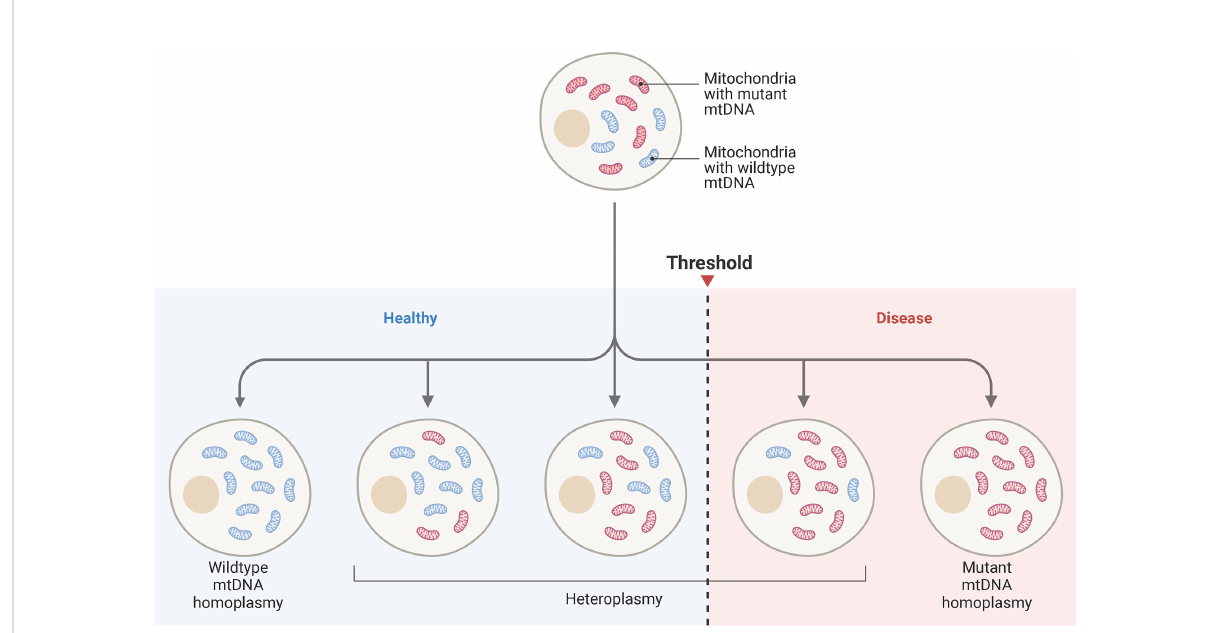
FIGURE 5 Mitochondrial Heteroplasmy and Disease ThresholdSchematic representation of mtDNA heteroplasmy and disease threshold. Blue mitochondria represent wild-type mtDNA, while red mitochondria represent mutant mtDNA. A cell may harbor all wild-type mtDNA, while others accumulate mutant mtDNA. The ratio of wild-type to mutant mtDNA can vary from cell-to-cell. When a pathogenic threshold is reached, a disease phenotype may emerge. The threshold depends on the pathogenicity of the mutation and bioenergetics the tissue. Cardiac tissue has high energy requirements, so a low mutant mtDNA may result in cellular dysfunction. Adapted from “ mtDNA Heteroplasmy ” , by www.BioRender. com. Retrieved from https://app.biorender.com/biorender-templates